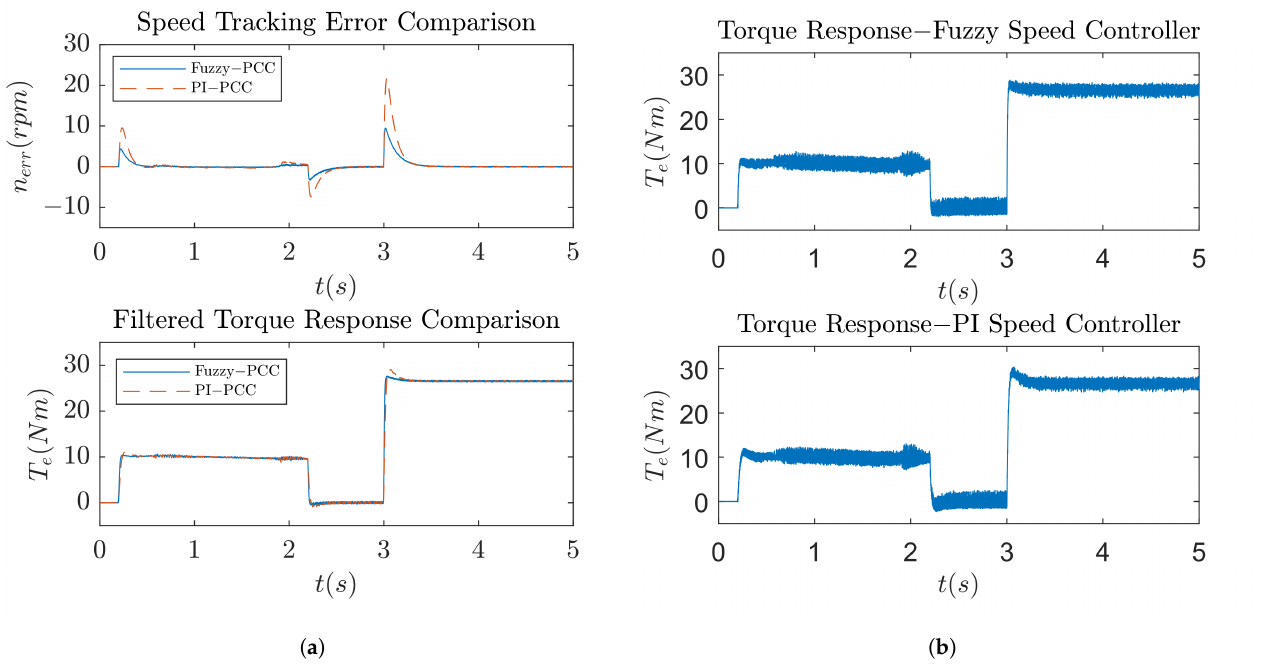
Figure 13. System response comparison between proposed method and classic PCC